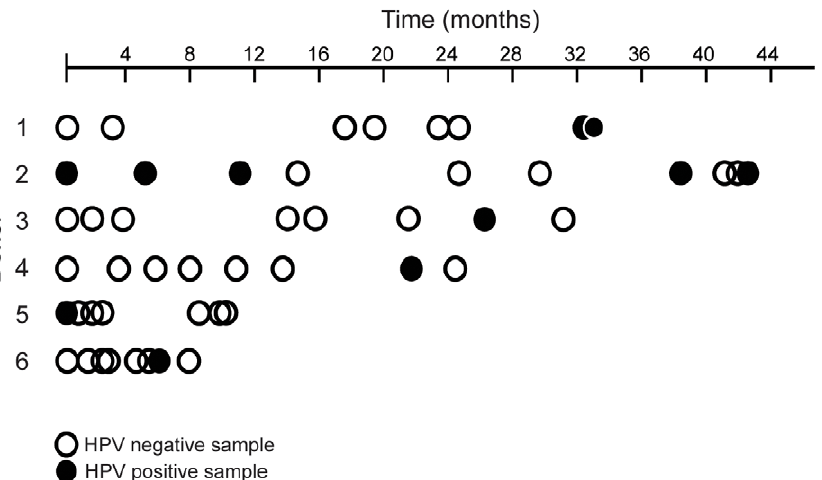
Figure 2. Longitudinal analysis of HPV-positive sperm samples. HPV is not continuously shed in semen. Circles on a relative time scale image series of ejaculates from 6 different donors, occasionally positive for an HPV. Filled circles represent HPV positive samples; open circles represent HPV negative samples. Starting points are given by the first analyzed ejaculate for each donor. Series of ejaculates from six different donors were found positive for HPV type 84; type 53, 31, and 52; type 62; type 61; type 54; and type 52, respectively.